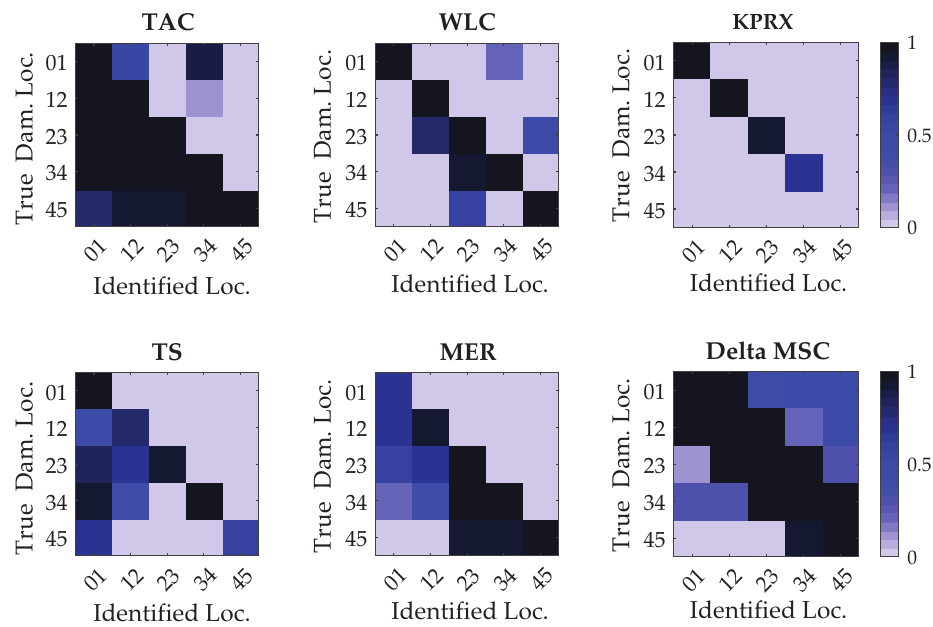
Figure 11. Overview of damage localization perormance of six DSFs: TAC , WLC , KPRX , TS , MER , and ∆ MSC . While the true damage location is generally identified—except for KPRX and TS in the last floors, only KPRX does not produce false detection for linear elastic